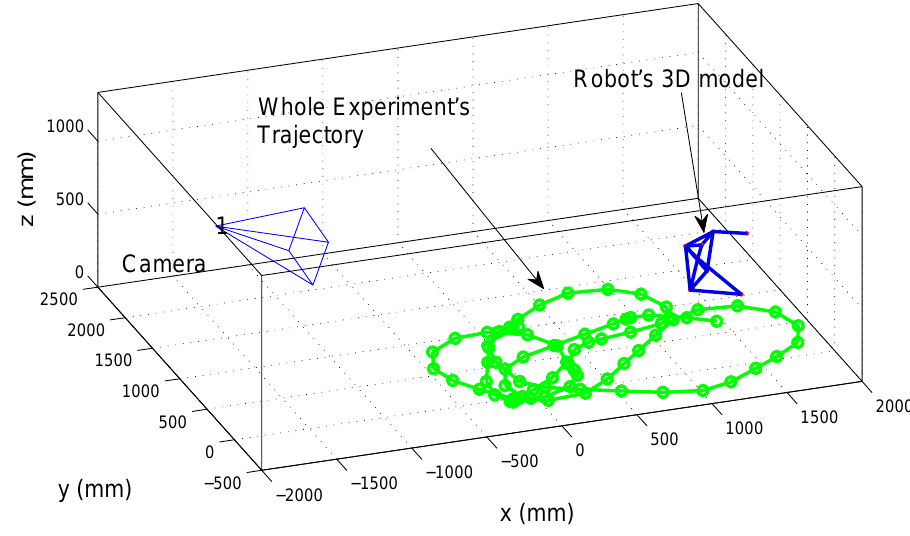
Figure 7. Geometric distribution of the camera and robot’s trajectory.